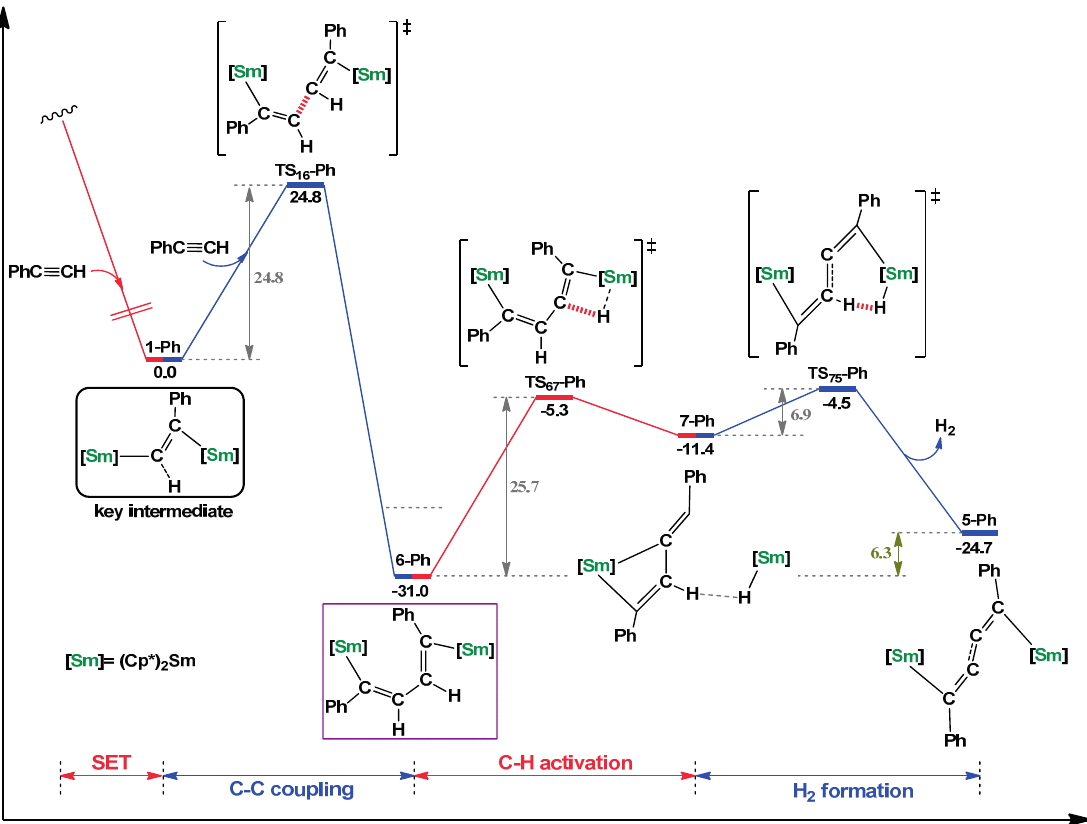
Figure 4. Enthalpy energy Δ H (kcal·mol − 1 ) profile for the formation of the corresponding trienediyl complex using PhC ≡ CH as substrate and (Cp * ) 2 Sm as a precursor (mechanism A). Cp * ligands are omitted for